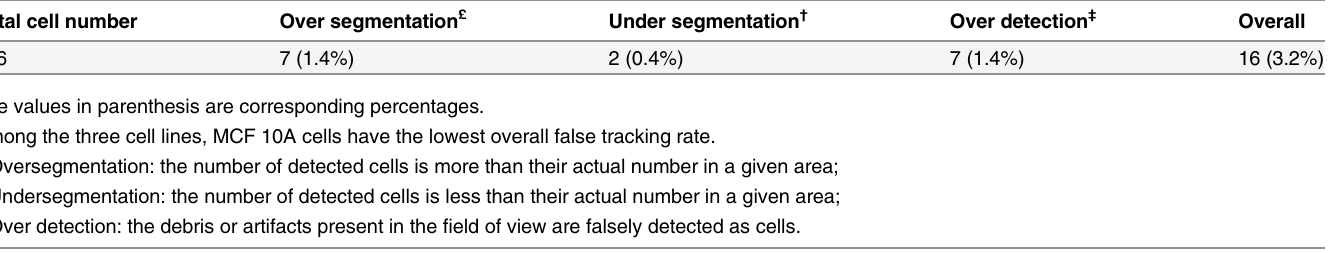
Table 1. Summary of the false segmentation rates obtained with the proposed